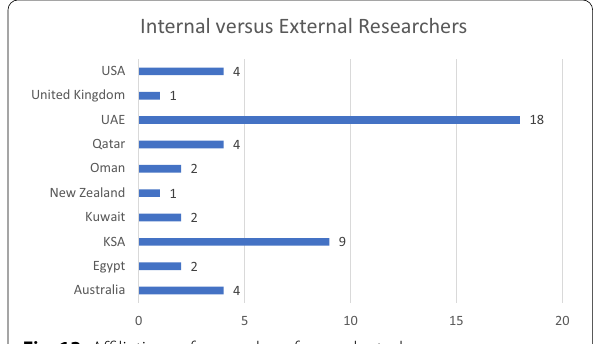
Fig. 13 Affiliations of researchers from selected